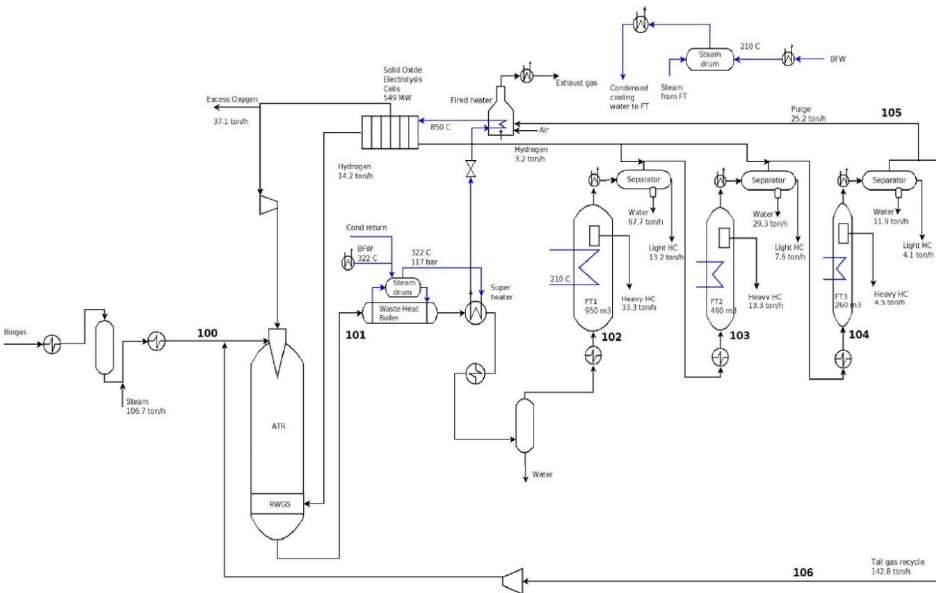
Figure 9. Detailed diagram of staged biogas-to-liquids production. Steam streams are indicated by a blue color. Table 3 shows the stream specifications, labelled by bold text tag numbers.